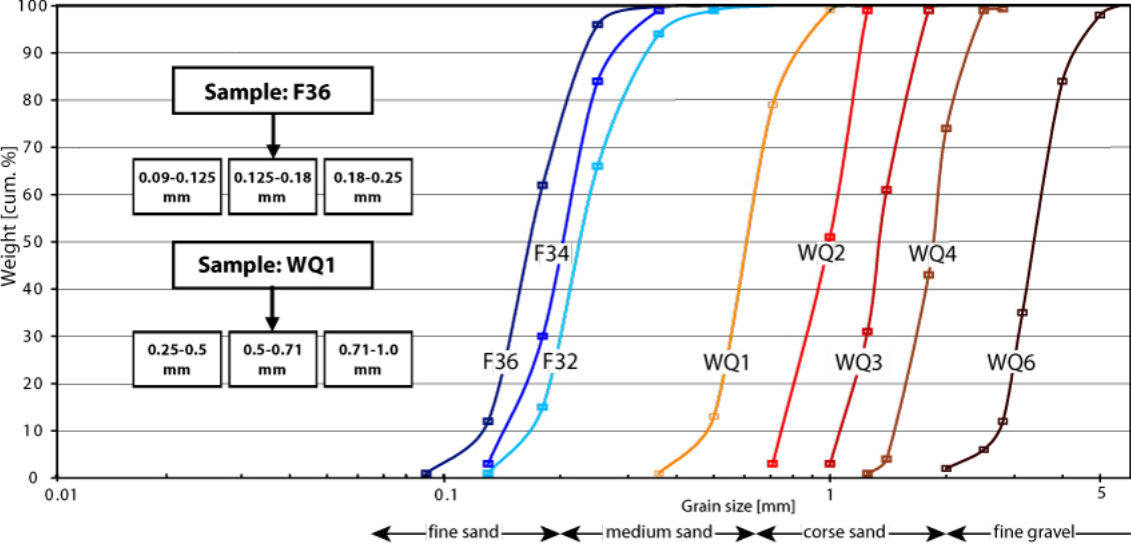
Fig. 1. Grain size distribution curves for the different samples considered in this study. Left: Six sieved fractions originating from sands F36 and WQ1. Right: Grain size distributions of unsieved industrial granular quartz samples. See also Table 1. Table 1. Table of the original, unsieved samples and their effective and medium grain sizes d 10 and d 50 , respectively, and their level of sorting as defined by d 60 / d 10 . F36 F34 F32 WQ1 WQ2 WQ3 WQ4 WQ6 Aggregate Fine Medium Medium Medium Coarse Coarse